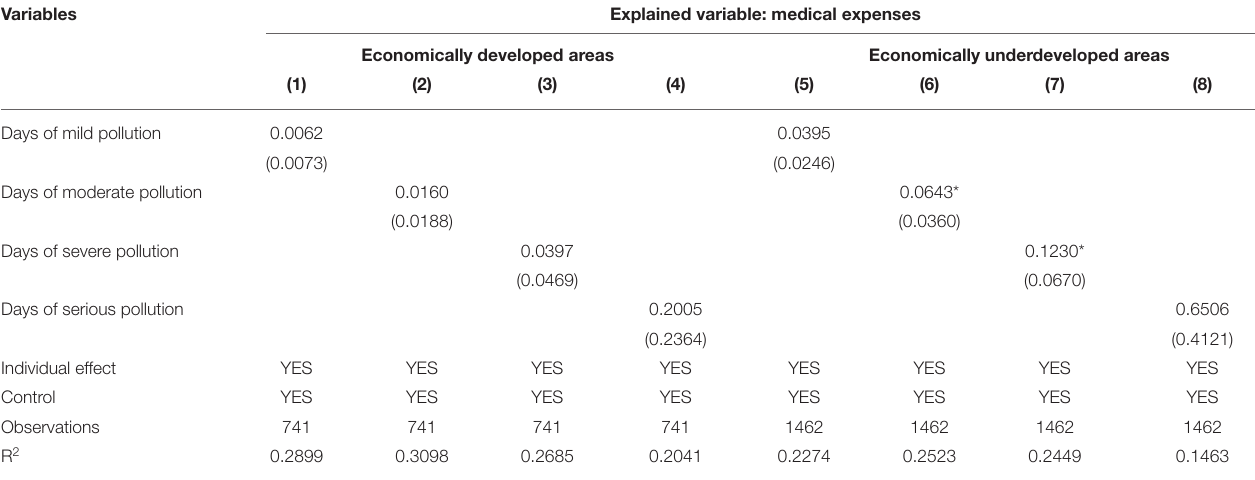
TABLE 8 | Regional economic heterogeneity: air pollution and medical expenses.